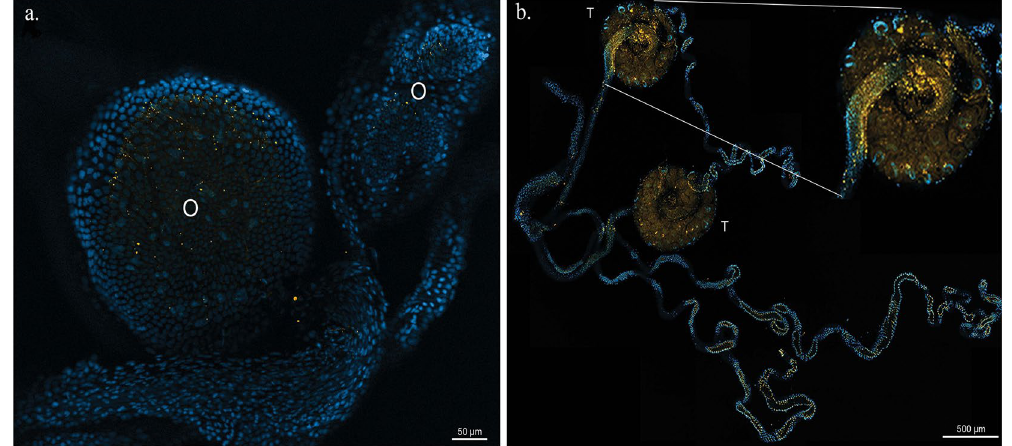
Figure 7. Localization of Spiroplasma in the male and female reproductive system of Gff . In fluorescent in situ hybridization (FISH) images blue and yellow indicate insect nuclear DNA and Spiroplasma respectively. ( a ) FISH on dissected ovaries (O), ( b ) FISH on dissected testes (T) with an inset showing a testis at a higher